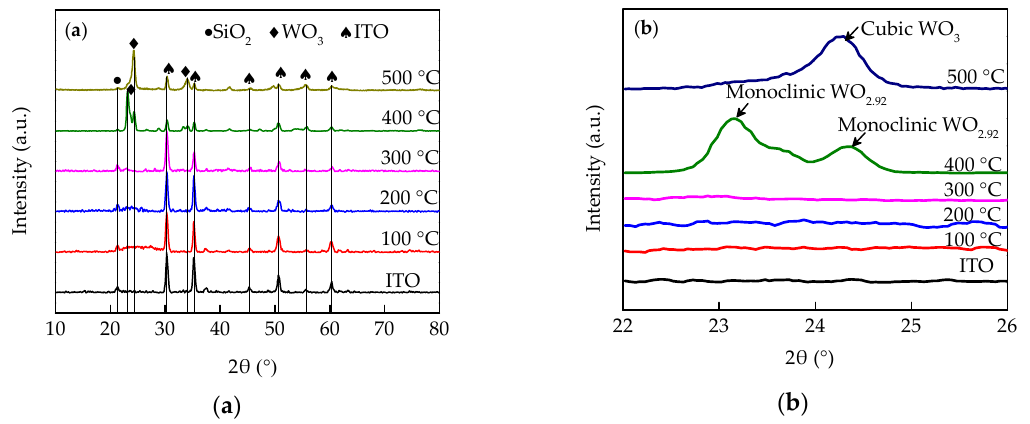
Figure 1. X‐ray patterns of WO 3 films annealed at different temperature. ( a ) The XRD patterns in a large range of 2θ (10° to 80°); ( b ) The XRD patterns in a small range of 2θ (22° to 26°). The amorphous WO 3 transformed into monoclinic structure and cubic structure at 400 °C and 500 °C, respectively.